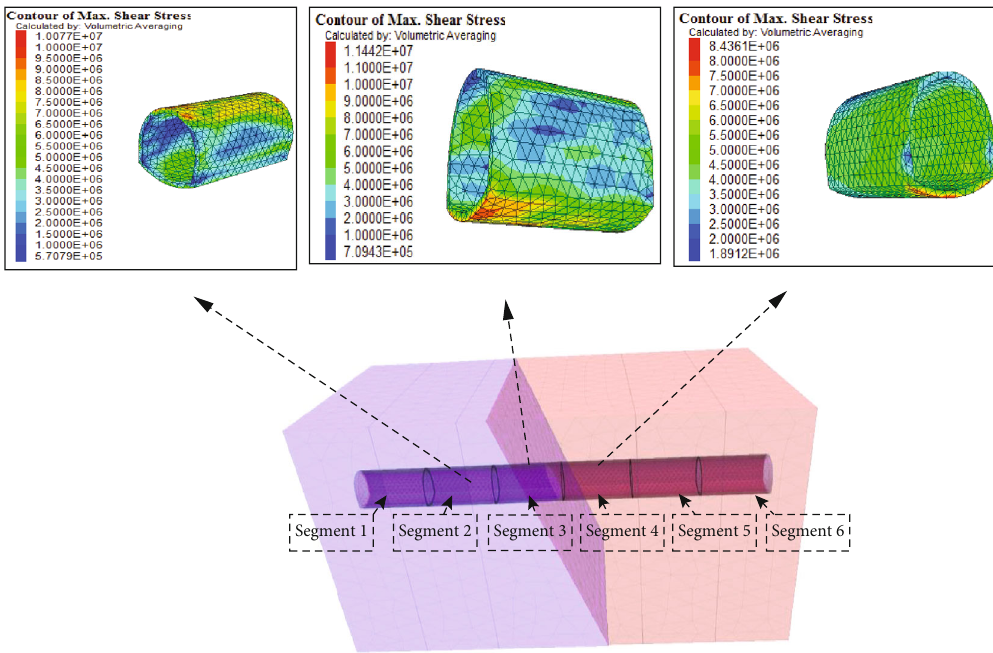
Figure 7: Maximum shear stress nephogram (units: Pa).